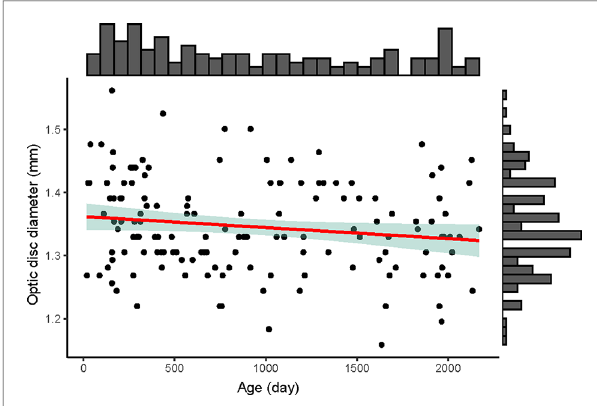
FIGURE 2 The distribution of optic disc diameter (mm) with age (day) of the 146 included children. The upper histogram showed the distribution of the age (day) and the right histogram showed the distribution of the optic disc diameter (mm). The red line was the linear regression line (y= − 0.00002x+1.362), showing no changes of optic disc diameter among different age. The green shadow area was the 95% con fi dence interval of the linear regression